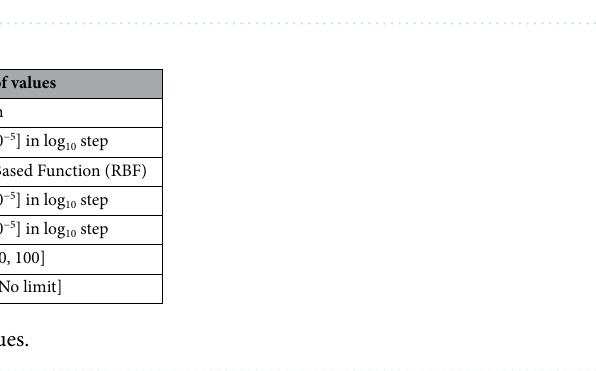
Figure 5. Ensemble of machine learning algorithms. ( a ) Bagging: Train several classifiers for each feature and combine the results by the soft voting. ( b ) Stacking: Use the predictions from multiple weak classifiers to train a model.